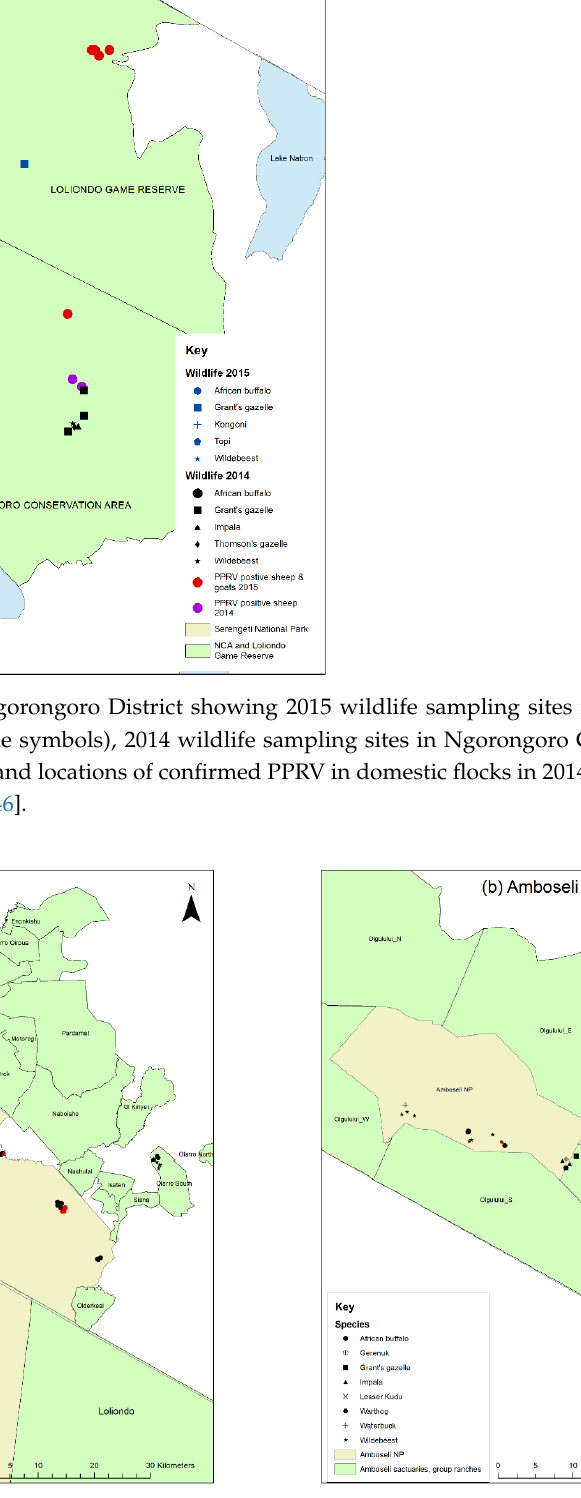
Figure 5. Maps of the 2016 wildlife sampling sites in Kenya: ( a ) the Mara ecosystem; ( b ) the Amboseli ecosystem. Sampling sites of seropositive animals are shown by red symbols. In the Amboseli ecosystem, 57 animals from 8 species were sampled (Figure 5b) The distribution of positive sera by age of the wild animals sampled is shown in Fig- ure 6. The ages of nine animals were not recorded (eight seronegative and one seroposi- tive), so these were excluded from this figure. Seropositive animals were aged between six months and seven years. There was no evidence of an association between age and presence of antibody, using univariable logistic regression, although the sample size may have been too small to detect an association. There was no evidence of an association be- tween sex and serological status. Most of the animals sampled in Tanzania were in good body condition (61%), while a few had average (22%) or very good (17%) body condition, and all were categorised as healthy.